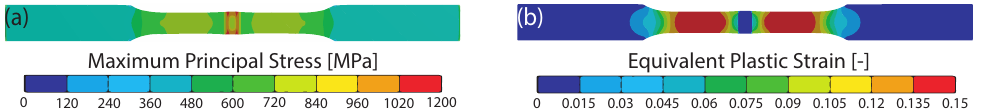
Figure 5. Finite element simulation of the tensile test with a hard weld seam located in the middle of the specimen and soft base material, ( a ) Maximum Principal Stress, ( b ) Equivalent Plastic